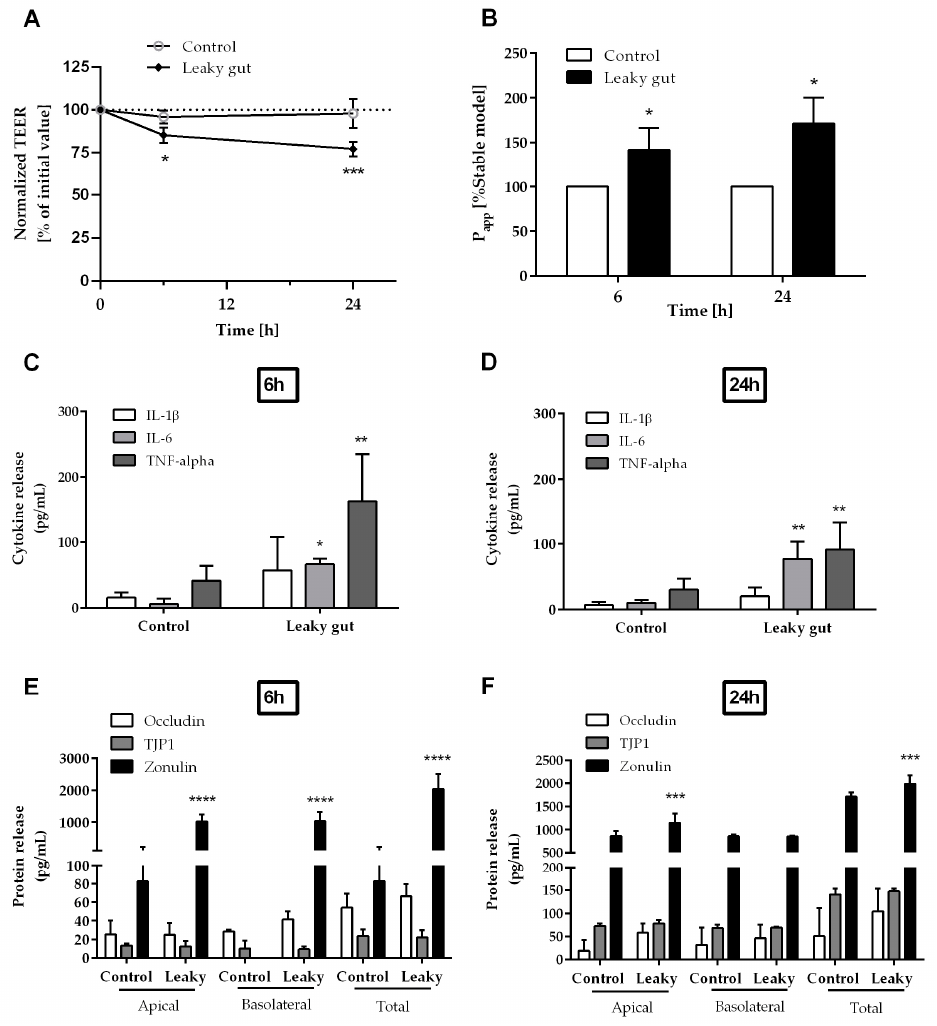
Figure 5. Characterization of the in vitro “leaky gut” model. Intestinal barrier function of the triple cell culture was assessed by ( A ) TEER and ( B ) permeability value (P app ) after 6 h and 24 h incubation. The secretion of the key pro-inflammatory cytokines IL-1 β , IL-6, and TNF- α in the basolateral compartment were quantified after ( C ) 6 h and ( D ) 24 h. The release of Occludin, Tight Junction Protein-1 (TJP1), and Zonulin in the apical, and basolateral compartment were measured after ( E ) 6 h and ( F ) 24 h. Data are given as mean ± SD ( n ≥ 3). * p < 0.05, ** p < 0.01, *** p < 0.001, **** p < 0.0001 as compared to the control model.